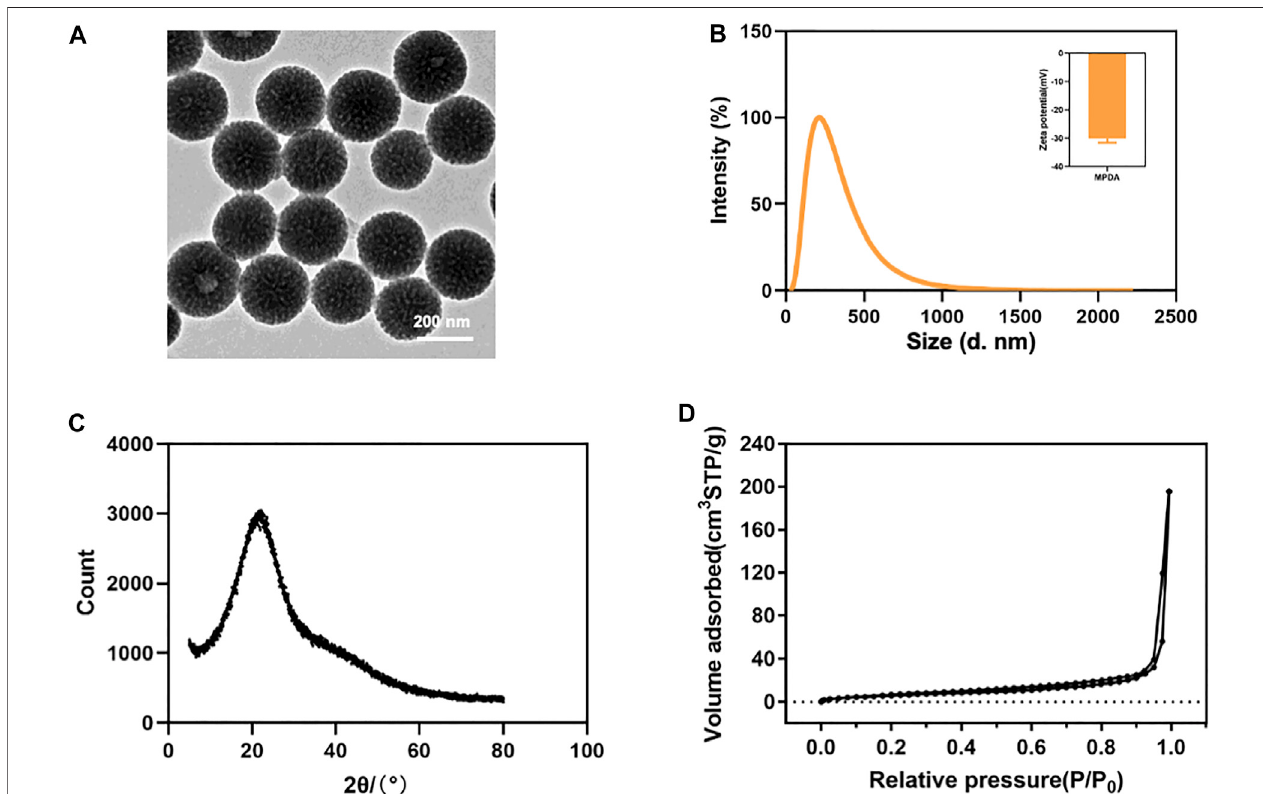
FIGURE 1 | (A) TEM image of MPDA NPs. (B) Size distribution and zeta potentials of MPDA NPs. (C) XRD spectrum of MPDA NPs. (D) N2 adsorption-desorption isotherms of MPDA